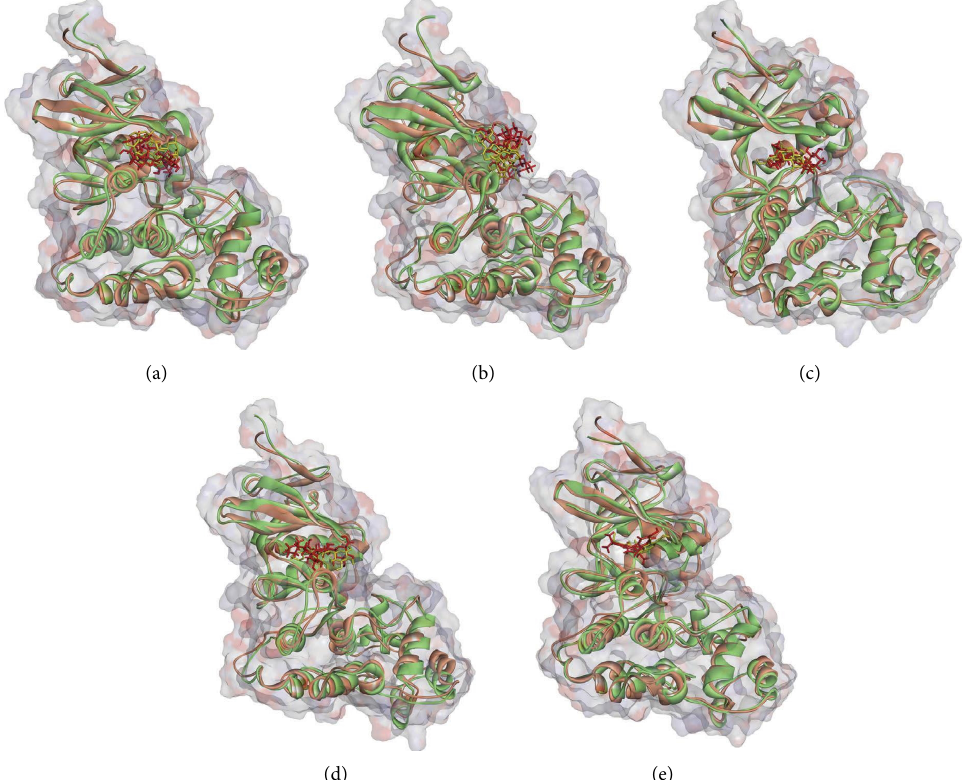
Figure 4: Superimposed structures of MAPK3 complexed with (a) kaempferol 3-rutinoside-4 ′ -glucoside, (b) kaempferol 3-rutinoside-7- sophoroside, (c) rutin, (d) vicenin-2, and (e) pulvalanol before and after MD simulation analysis. Brown and green colors illustrate proteins before and after 100ns MD simulations. Yellow and red compounds demonstrate ligands before and after MD analysis, respectively. MAPK3, mitogen-activated protein kinase